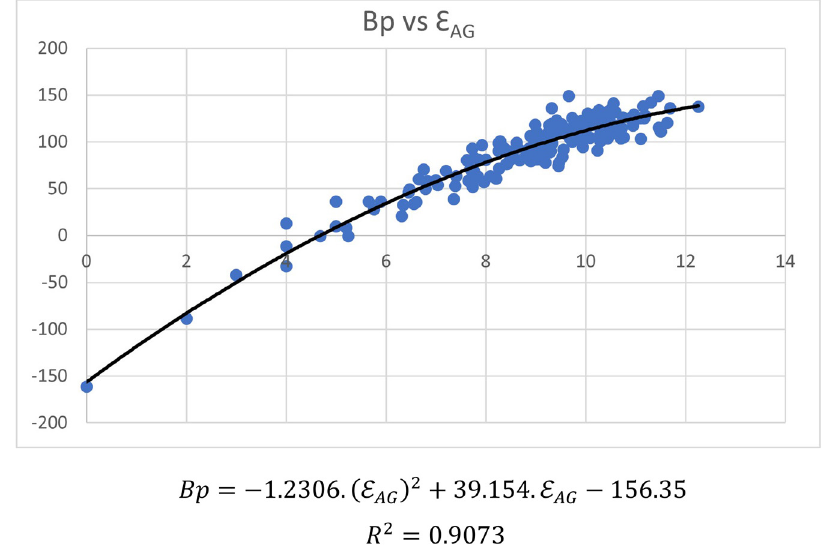
Figure 7: Quadratic regression Bp versus . AG